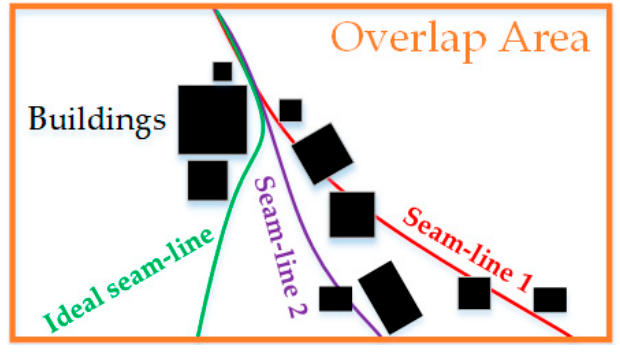
Figure 2. The sketch map of search results for seam lines.